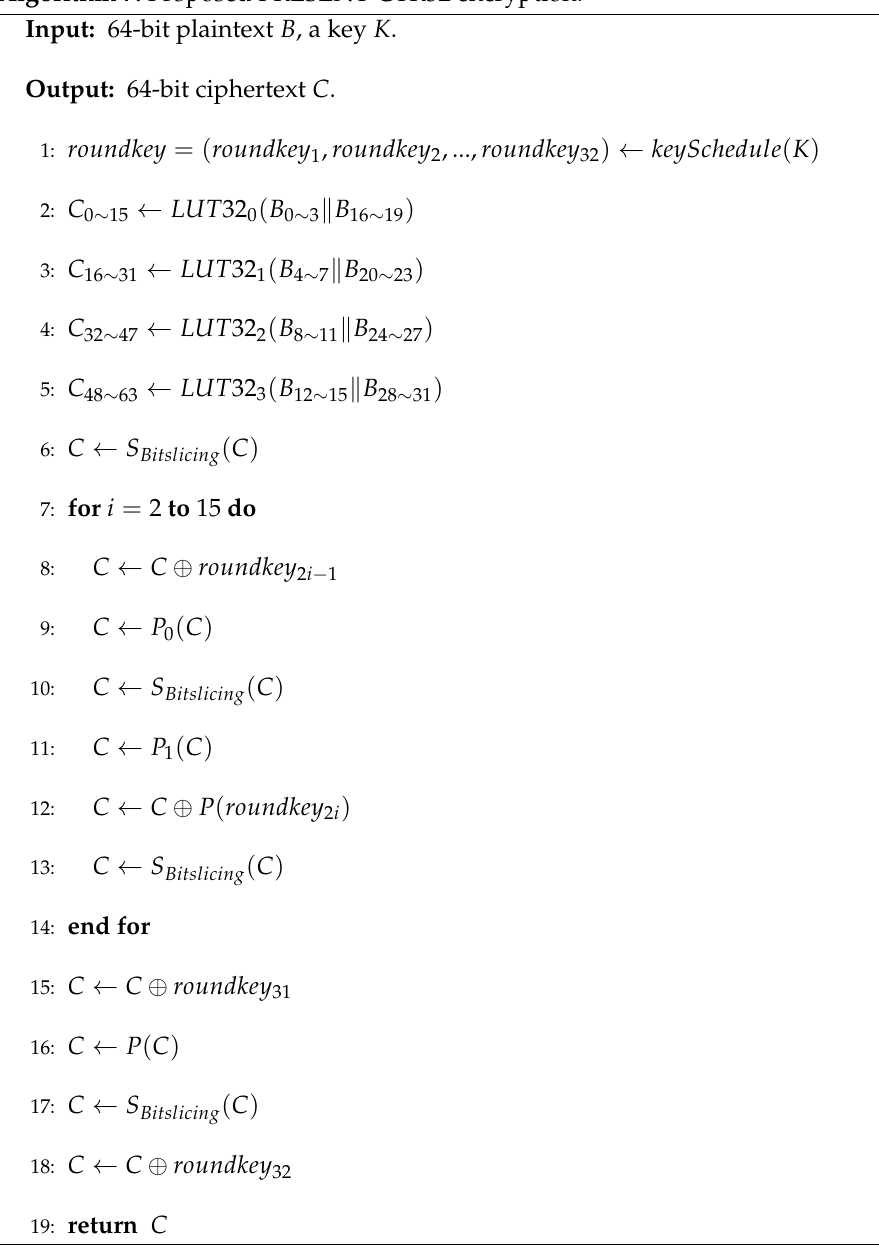
Algorithm 7: Proposed PRESENT-CTR32